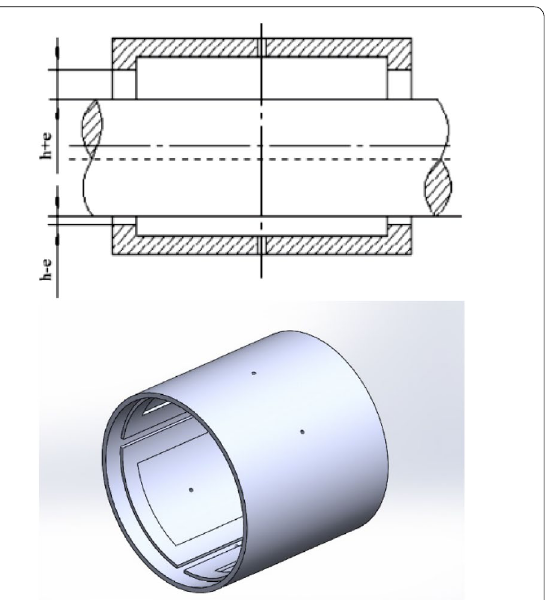
Figure 5 Conventional four-pad hydrostatic support